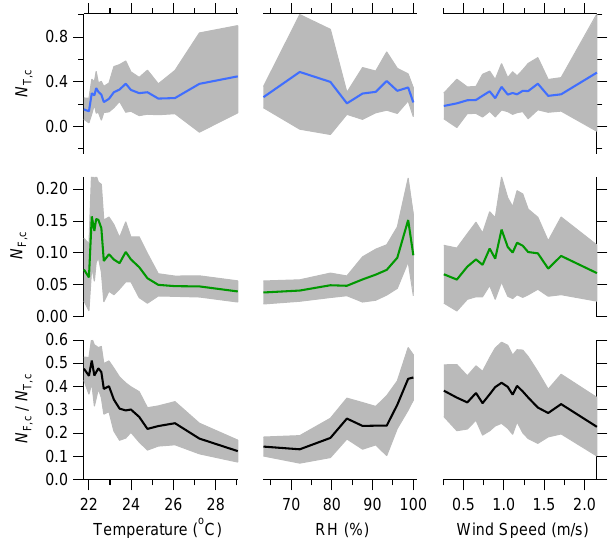
Fig. 11. Correlations of UV-APS particle number ( N T , c , N F , c , and N F , c / N T , c ) with meteorological parameters (temperature, relative humidity, and wind speed). Colored line indicates campaign mean value and gray shading indicates plus and minus one standard devi-